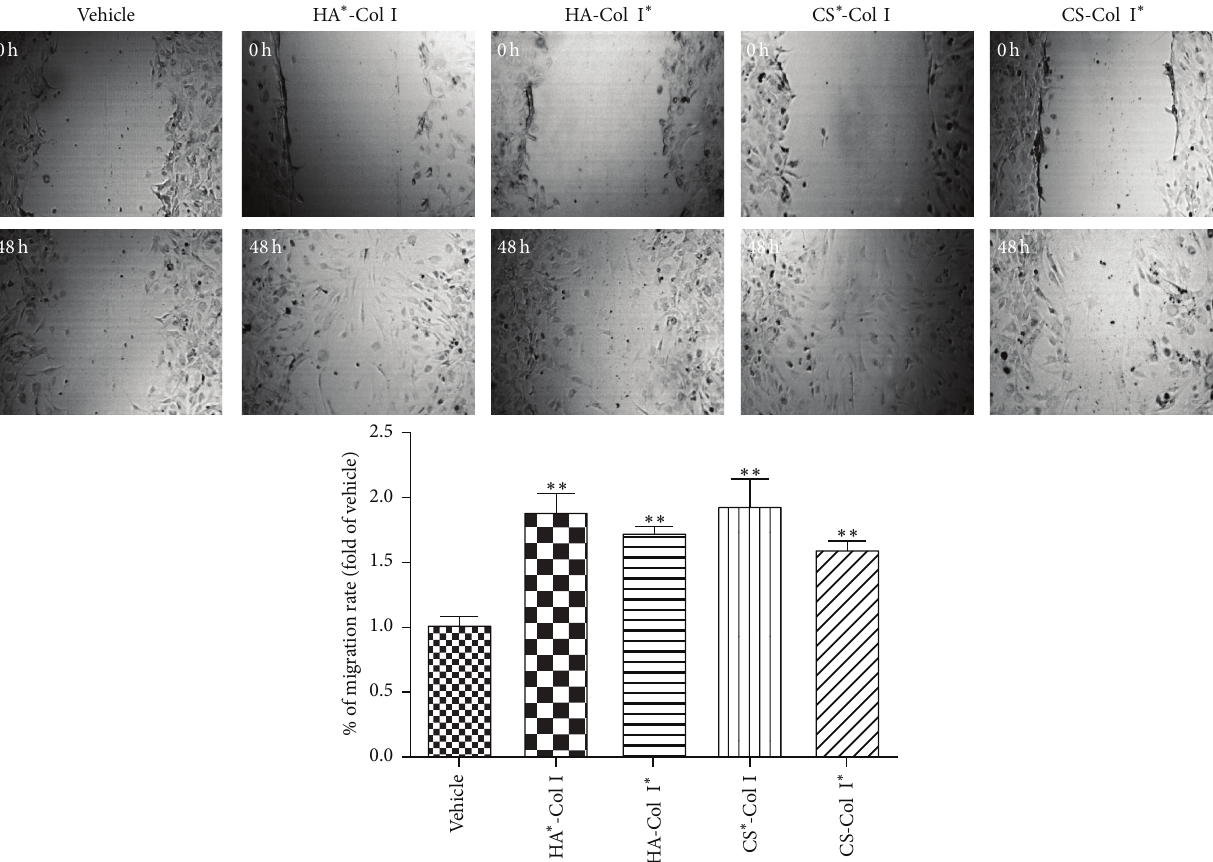
Figure 3: Effects of multilayer composite biomaterial membranes on the migration of EPCs. ∗∗ 𝑝 < 0.01 versus vehicle, 𝑛 = 3